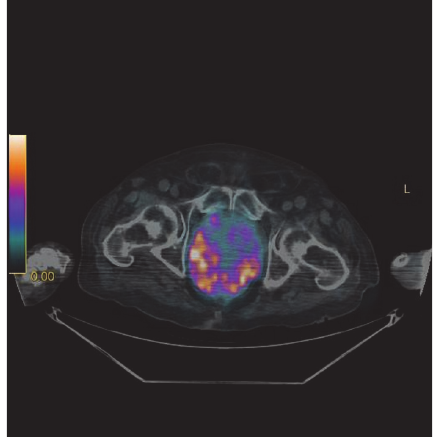
Figure 2: 68 Gallium DOTATATE PET/CT image showing a high and diffuse uptake of the